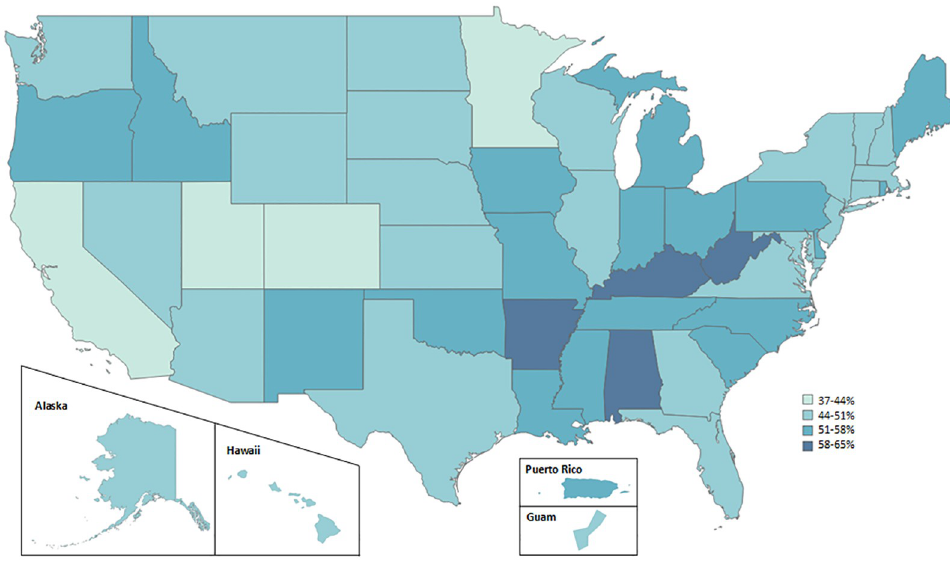
Fig 1. Prevalence of diagnosed multiple chronic conditions among adults aged � 18 years, by state or territory— Behavioral Risk Factor Surveillance System, United States, 2017.